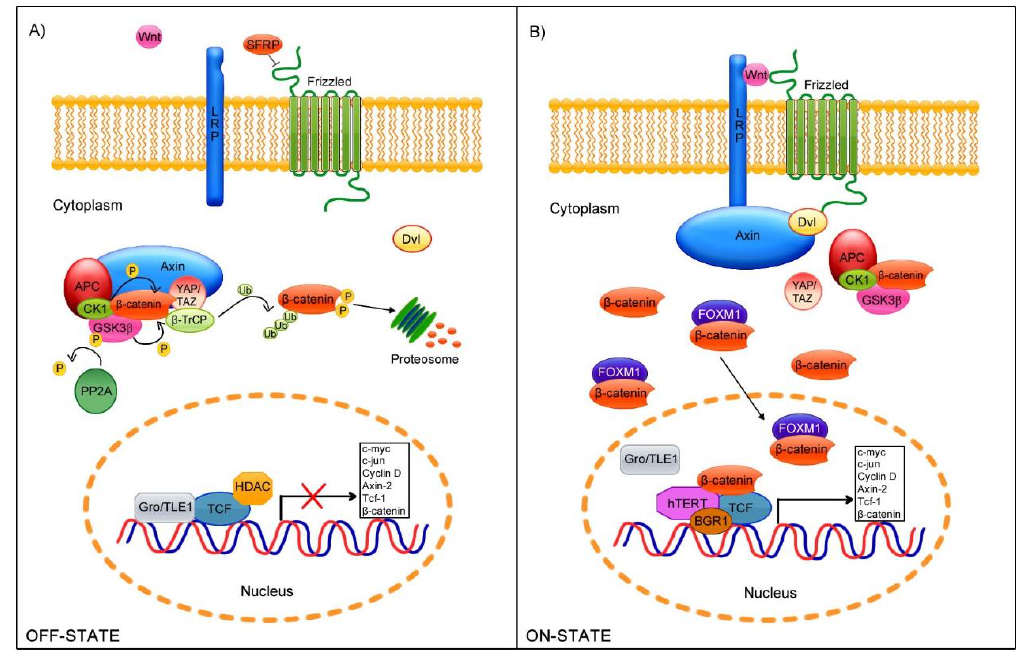
Figure 1. Wnt/β-catenin cell signaling pathway. ( A ) In the absence of stimuli (OFF-STATE), the Fz receptors are regulated by a group of antagonist proteins, such as SFRP, which prevent further receptor-ligand interaction. In the cytoplasm, a degradation complex is formed, to which β-catenin is recruited and phosphorylated at specific residues by the GSK3β and CK1 kinases. These phosphorylated sites are recognized by βTrCP ubiquitin ligase, which mediates β-catenin proteosomal degradation. In the nucleus, the Groucho/TLE repressor binds to TCF/LEF, avoiding its transcriptional activation; ( B ) In the presence of Wnt ligands (ON-STATE), LRP5/6 and Fz dimerize; subsequently, Axin binds to LRP5/6, whereas Disheveled (Dvl) interacts with Fz, allowing Axin-Dvl binding and the disassembly of the β-catenin degradation complex. Finally, β-catenin is released in the cytoplasm and translocated to the nucleus, aided by its binding partner FOXM1, where it binds to TCF/LEF and detaches the Groucho/TLE